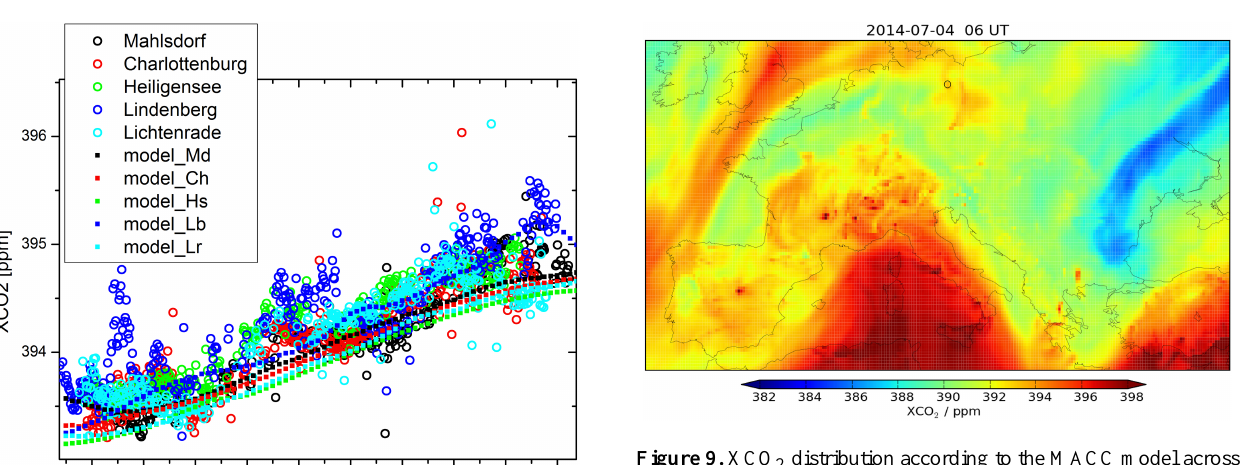
Figure 9. XCO 2 distribution according to the MACC model across central Europe for the morning of 4 July. North is up; orienta- tion marks are superimposed along the continental coastlines (dark lines). The open circle denotes the location of